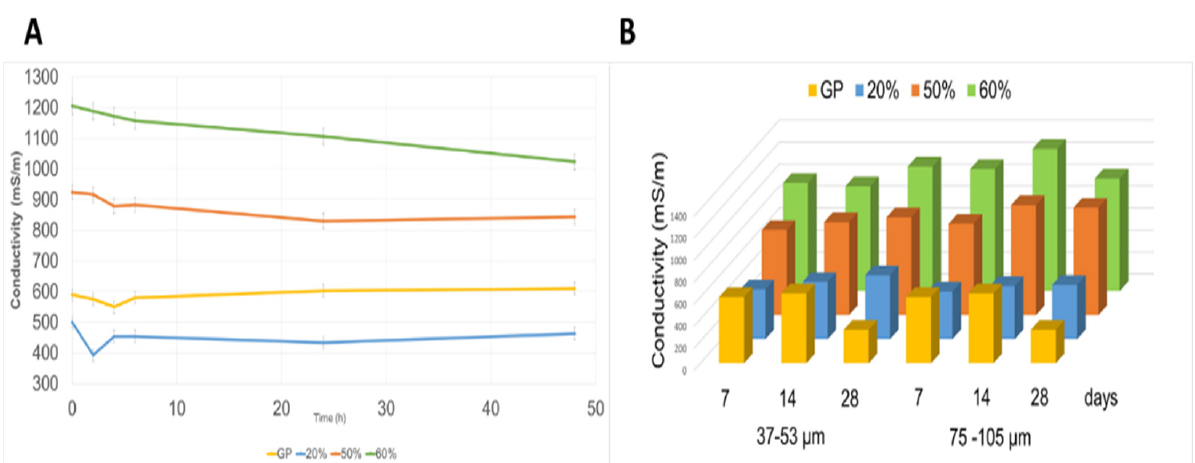
Figure 2. Ionic conductivity values reported: ( A ) vs. time for GP-WG (75–105 μ m) aged 7 days at different WG % and ( B ) for both series as a function of curing time and WG percentage.